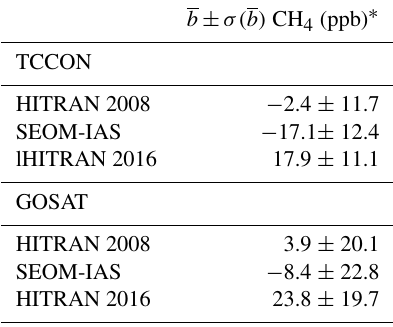
Table 2. Overview of the TCCON and GOSAT validation results (mean bias and its standard deviation) for the TROPOMI XCH 4 retrieved with different spectroscopic